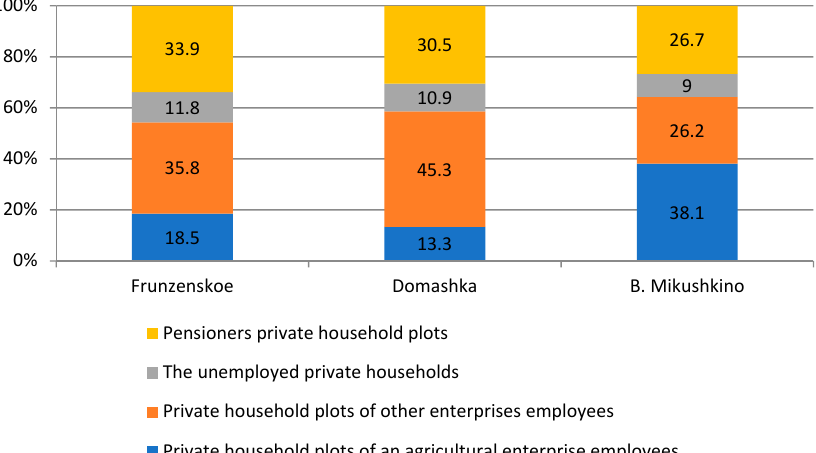
Figure 11. Comparison of private household plots by owners’ employment in 2014–2018.